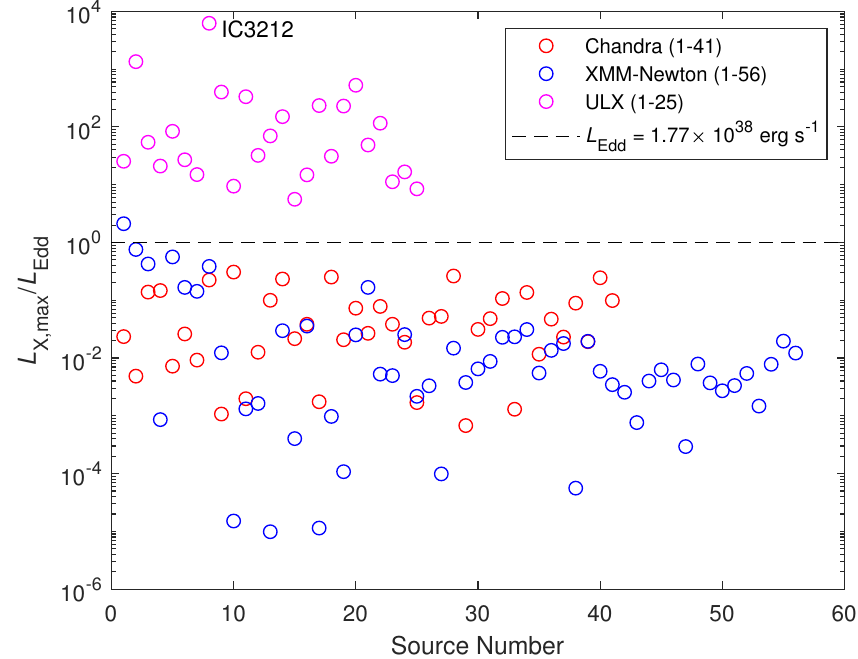
Figure 10. Maximum X-ray luminosities, scaled to the canonical Eddington luminosity L Edd of a 1.4 M (cid:12) neutron star, for our 3 main samples (1–3) in Section 2.